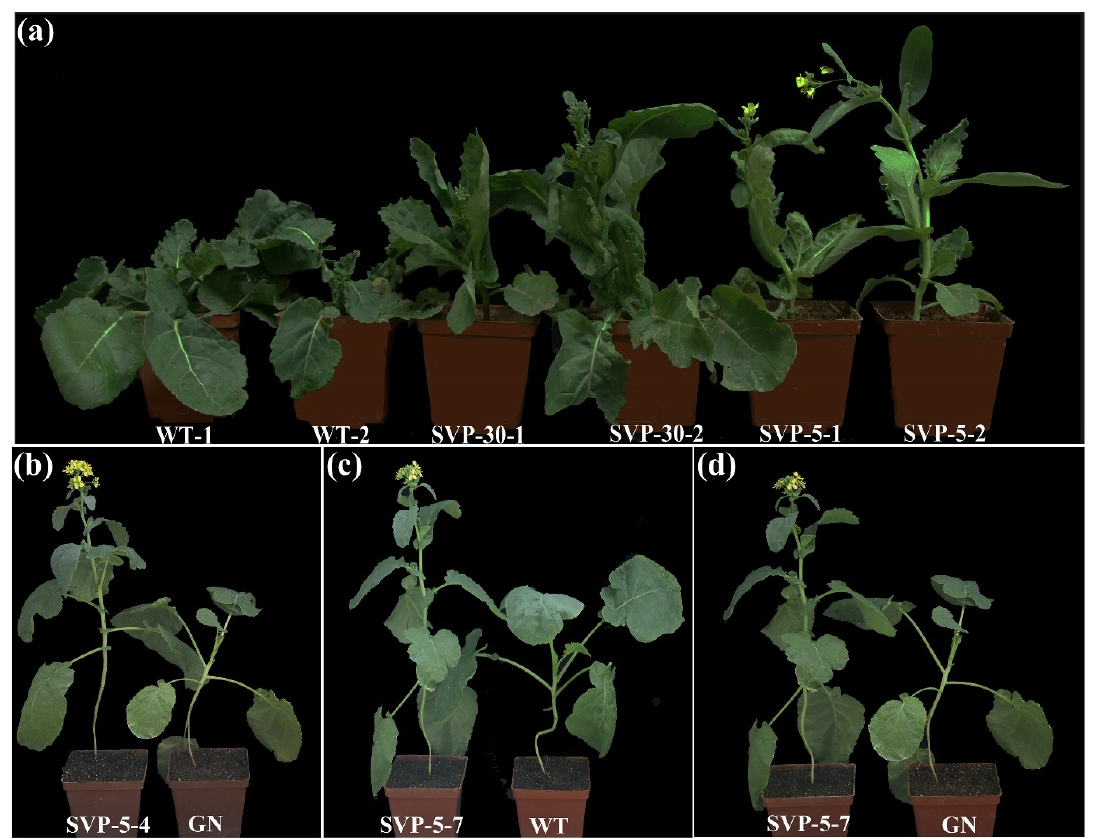
Figure 6. Flowering phenotype of the T1-generation svp mutant in outdoor and greenhouse environments. ( a ) The T1-generation svp mutant displayed the early flowering phenotype in the outdoor environment. ( b – d ) The T1-generation svp mutant displayed the early flowering phenotype in the greenhouse environment. WT indicates wild type, and GN indicates transgenic negative. Table 1. Analysis of the mutation types and flowering period differences for the T1-generation svp